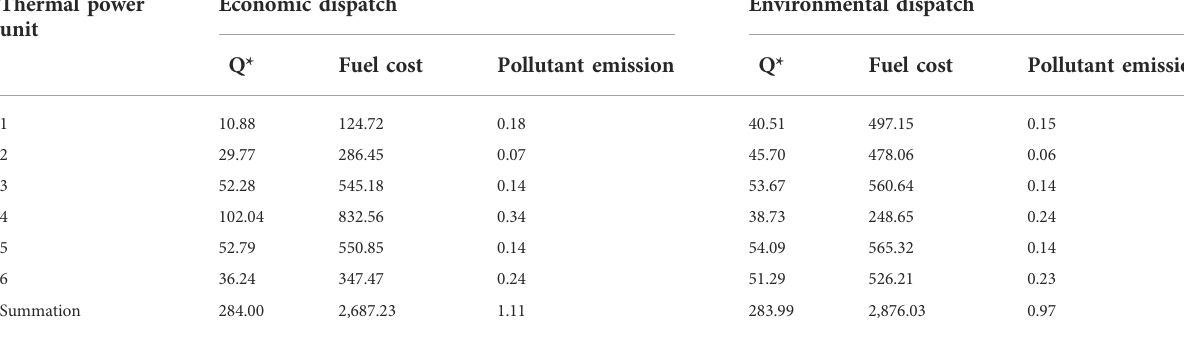
TABLE 2 Economic and environmental scheduling results with single-objective PSO algorithm. Thermal power